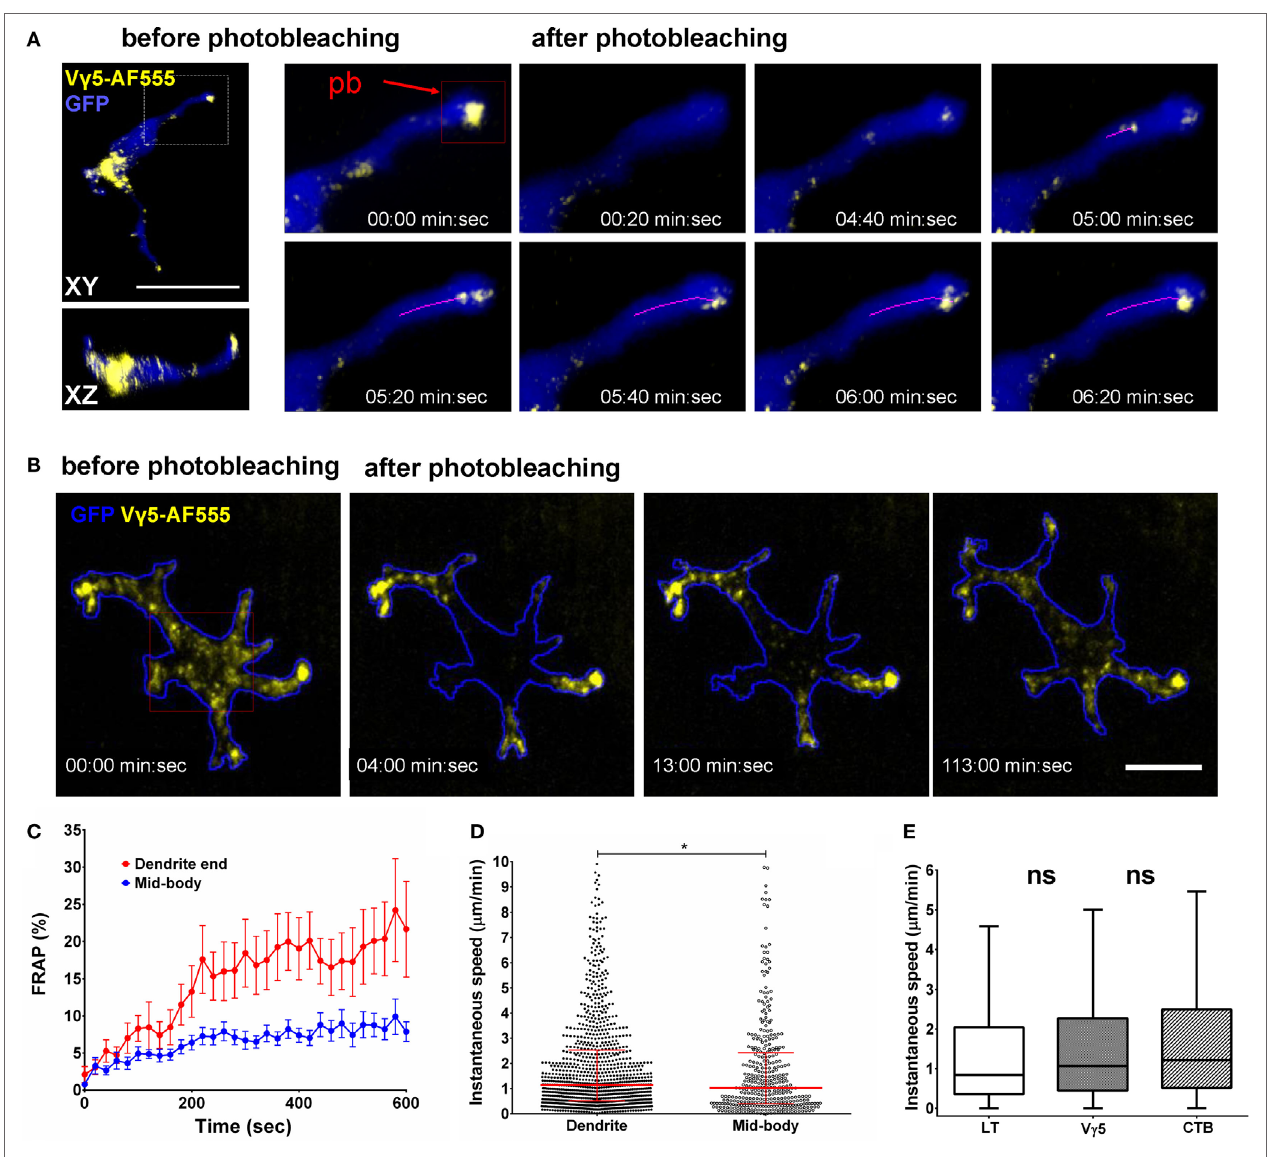
FigUre 5 | In vivo dynamics of dendritic epidermal T cell (DETC) granules labeled by intradermal anti-V γ 5-AF555. (a) Fluorescence recovery after photobleaching (FRAP) in an apical dendrite end. AF555 fluorescence was photobleached in the red rectangle area centered on the end of an apical-facing dendrite (pb) and the entire cell was imaged, in 3-D, every 20 s for 10 min. The magenta line represents a track of moving granule. (B) FRAP in DETC mid-body. The photobleaching was located in the red rectangle area. Cell outline based on GFP signal. (c) FRAP analysis, n = 15 cells in five mice. (D) Comparison of instantaneous granule velocities in DETC dendrites vs. mid-bodies. Each dot is the speed of a single vesicle, data pooled from n = 15 cells in five mice. The horizontal line and whiskers are the median and interquartile ranges. (e) Comparison of instantaneous granule velocities depending on labeling method. Data pooled from n = 15 cells in five mice, shown as box with median and interquartile range with Tukey whiskers. Scale bars = 10